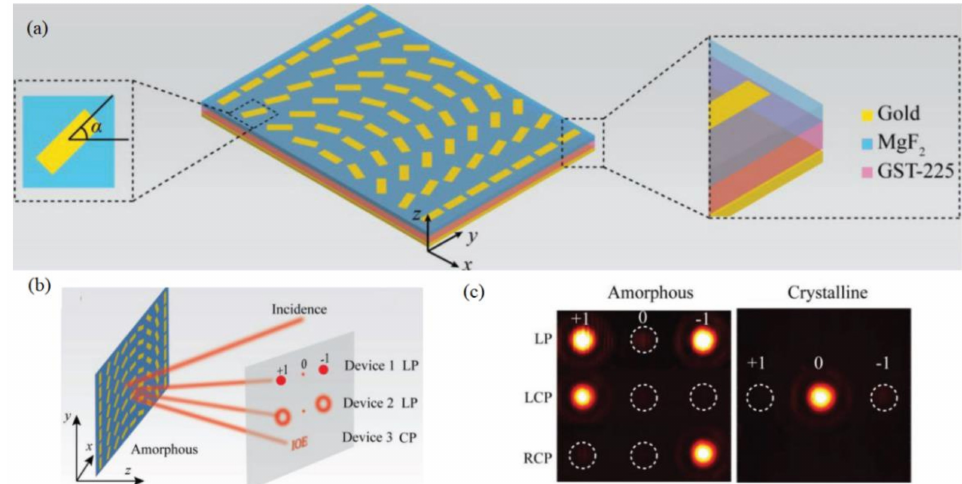
Figure 7. ( a ) Active metasurfaces with GST embedded in MIM setup for switchable SOI; ( b ) schematic of switchable SOI with the maximized cross-polarization in the amorphous state and ( c ) one device was demonstrated with switchable and selectable beam deflections. Left- and right-handed circular polarization (LCP and RCP, respectively) generated one beam with opposite deflections and linear polarization (LP) produced two symmetric deflections—( a – c ) all figures are reproduced with permissions from